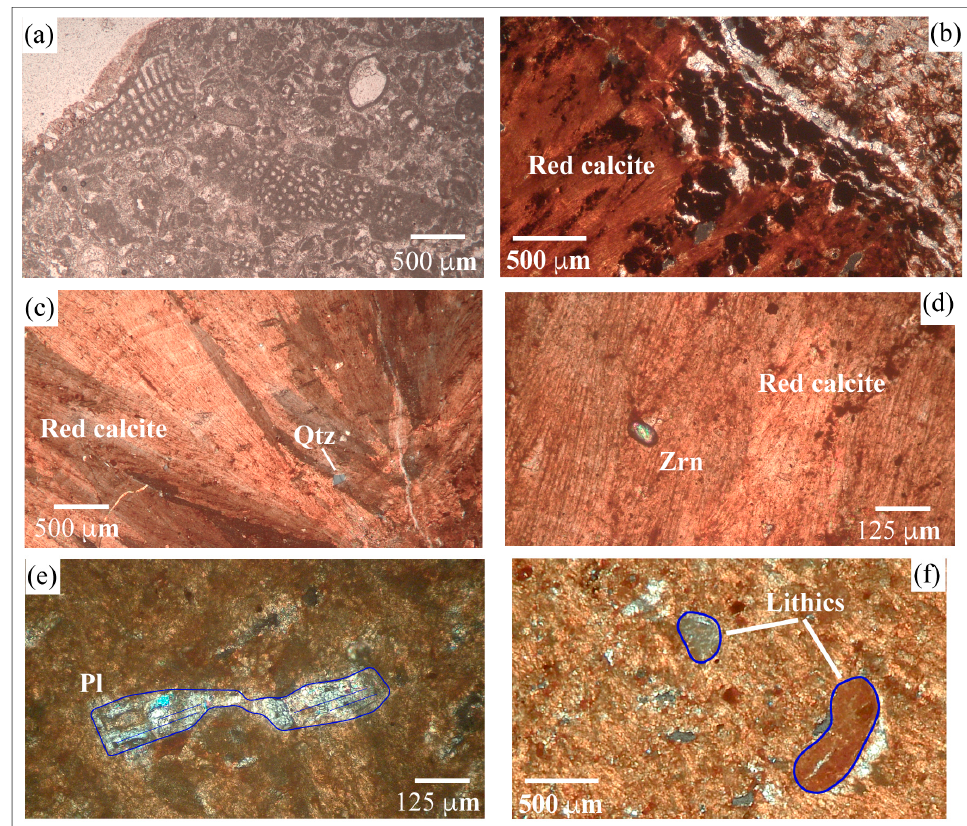
Figure 4. Microphotographs of studied samples: ( a ) Bioclastic packstone made up of abundant coated benthic foraminifers (CA4 sample, plane polarized light); ( b ) Gradual transition from intact limestone to weathered one, fading to the red calcite incrustation (CA2C sample, proceeding from NE to SW in the photo, plane polarized light); among red columnar calcite fibers in nodules are recognizable: ( c ) Monocrystalline quartz clasts (BA5L sample, crossed polarized light), ( d ) Zircon crystal (BA5L sample, crossed polarized light), ( e ) Partially preserved plagioclase crystal in which the typical polysynthetic twinning is detectable (BA5A sample, crossed polarized light); ( f ) Strongly altered polymineralic lithic fragments with a ghost porphyritic texture (BA5 sample, plane polarized light).